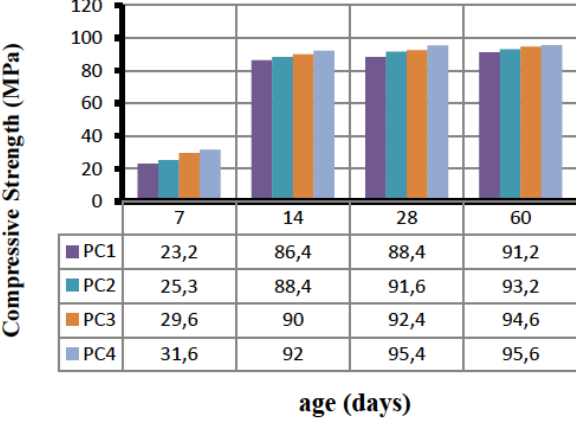
Figure 2: Influence of Sand Size on Compressive Strength of Poly- mer Concrete with Age